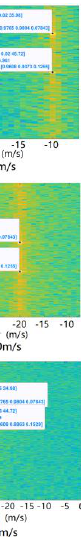
From the ground clutter modeling simulation, the position of the stationary vehicle in the RD